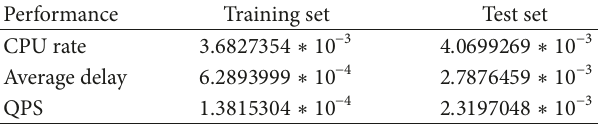
Table 7: Result of model of Song et al. on data set